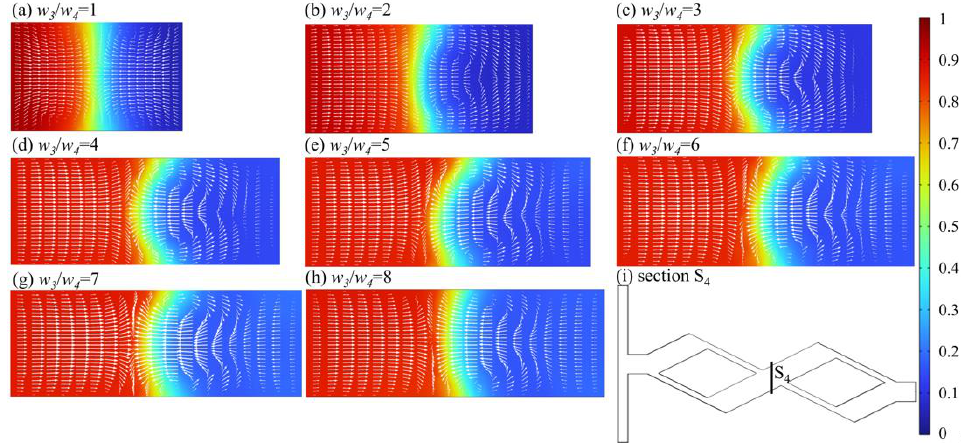
Figure 14. Concentration distribution and velocity vector of S 4 cross section at Re = 60. (a) w 3 /w 4 = 1; (b) w 3 /w 4 = 2; (c) w 3 /w 4 = 3; (d) w 3 /w 4 = 4; (e) w 3 /w 4 = 5; (f) w 3 /w 4 = 6; (g) w 3 /w 4 = 7; (h) w 3 /w 4 = 8; (i) Sec- ( b ) w 3 /w 4 = 2; ( c ) w 3 /w 4 = 3; ( d ) w 3 /w 4 = 4; ( e ) w 3 /w 4 = 5; ( f ) w 3 /w 4 = 6; ( g ) w 3 /w 4 = 7; ( h ) w 3 /w 4 = 8; tion S 4 ( i ) Section S 4